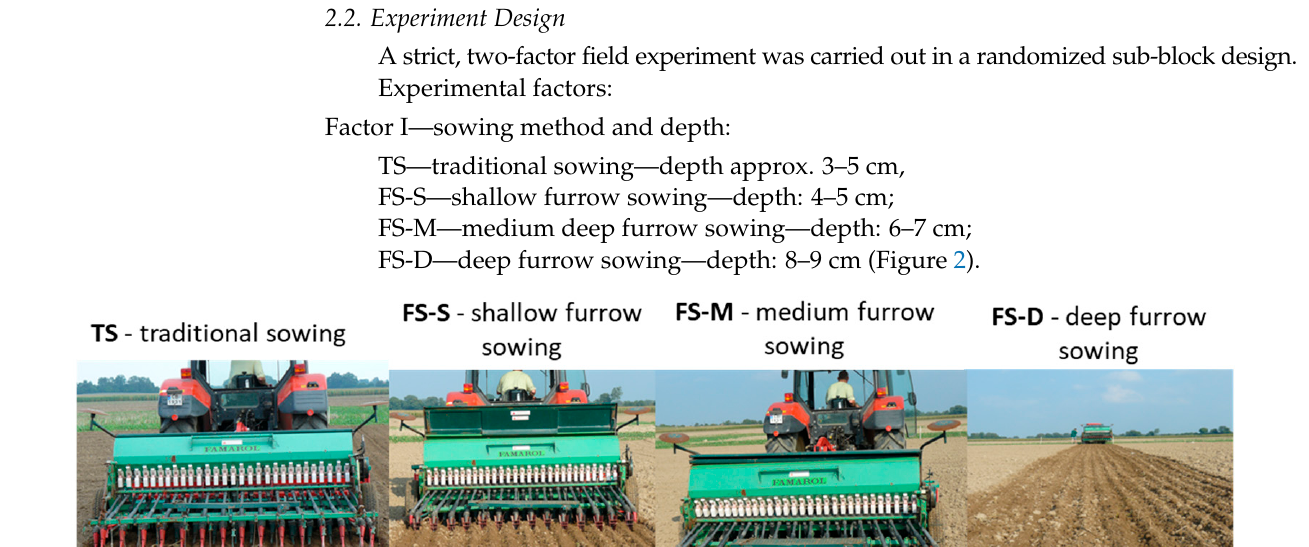
3 of 17 Figure 1. Site of field experiment at Moche ł ek, Kuyavian–Pomeranian voivodeship, Poland [20,21]. 2.2. Experiment Design